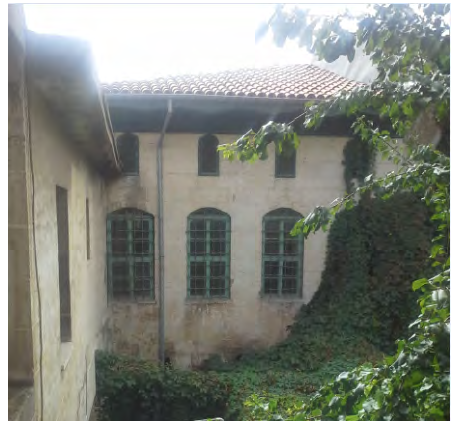
Figure 13. Bird Windows (Tas¸tan,2014)